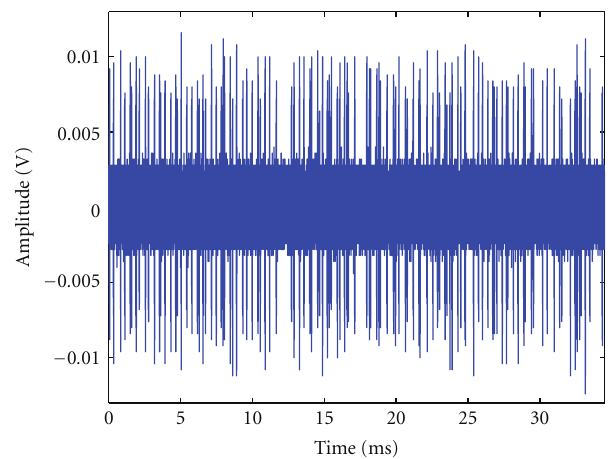
Figure 4: Recorded Wi-Fi signals in time